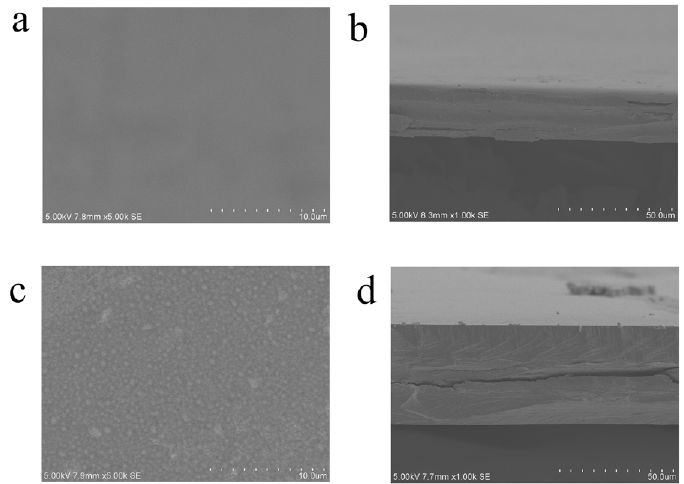
Figure 10. SEM images of ( a ) surface of pure sodium alginate (SA), ( b ) fracture surface of pure sodium alginate (SA), ( c ) surface of LBL2 film, and ( d ) fracture surface of LBL2 film. 3.8. X-Ray Diffraction (XRD) XRD is an essential method for analyzing the crystalline state of materials at the mo- lecular level and studying the properties and structures of crystalline materials. Accord- ing to Figure 11, the pure SA film had a strong diffraction peak b etween 2θ = 19.0° and 2θ